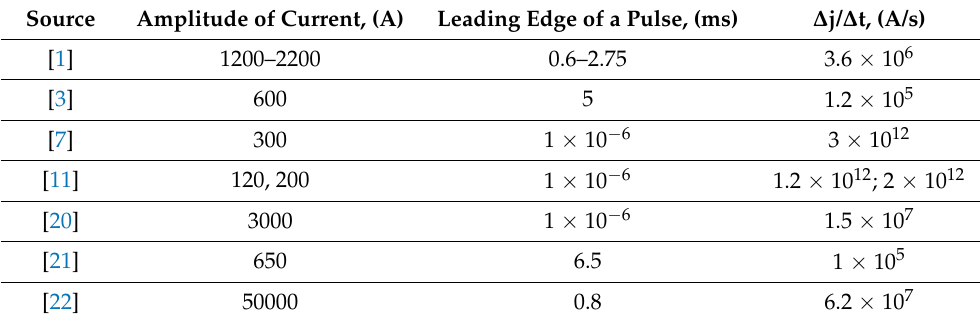
Table 8. Pulse processing